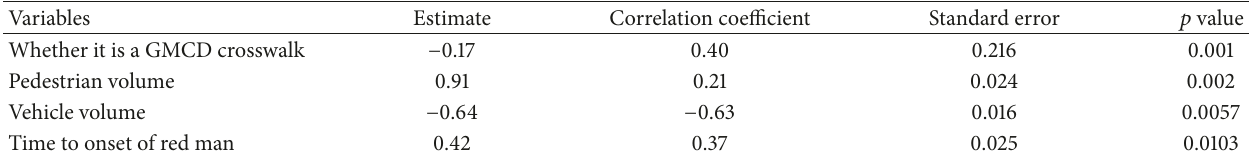
Table 5: Results of the estimated parameters for each independent